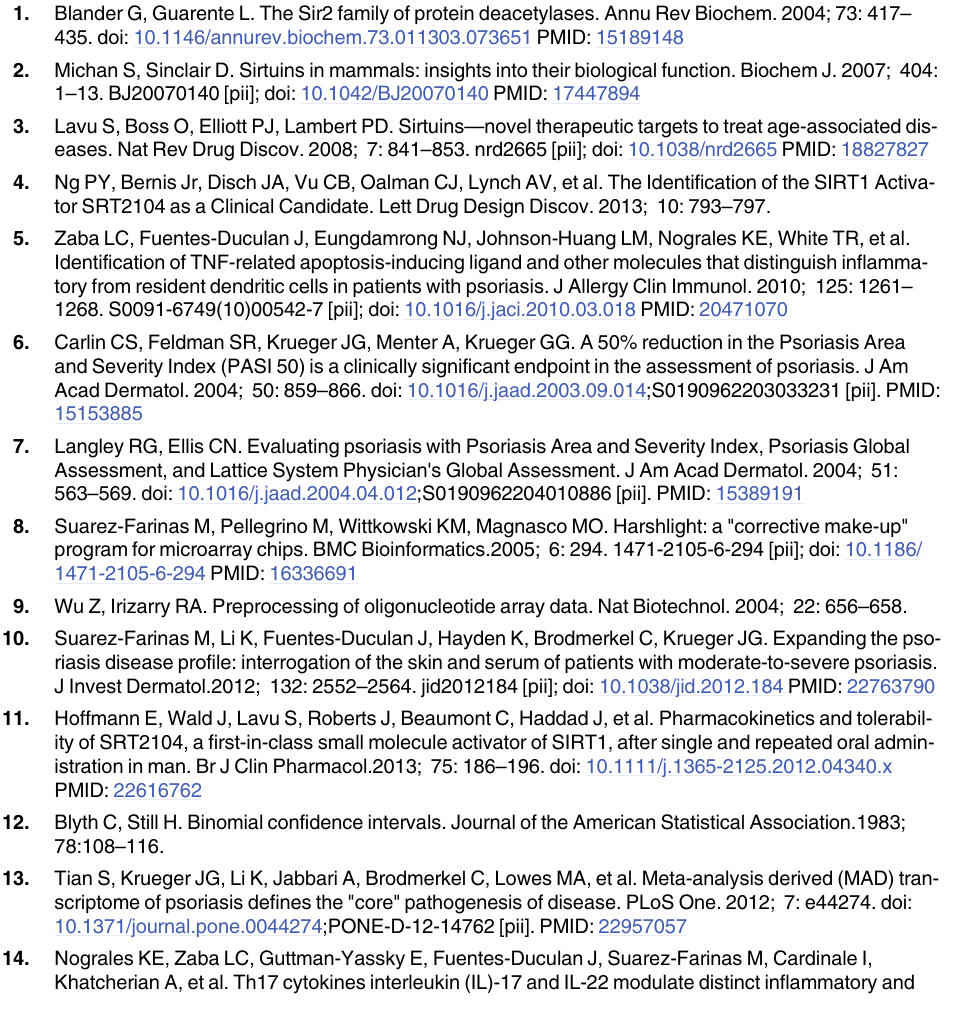
S1 Table. SRT2104 Pharmacokinetic Parameters by Treatment and Exposure groups. S2 Table. Proportion of Subjects Improvement Based on PGA Score – Day 84. S3 Table. Top Differentially Expressed Genes. S4 Table. GSEA Analysis of the Responder